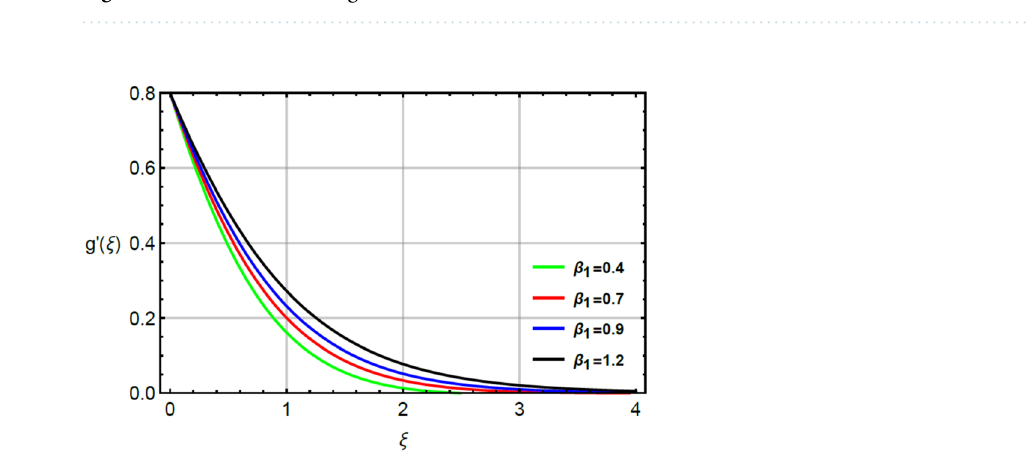
Figure 5. Character of M on g ′ .